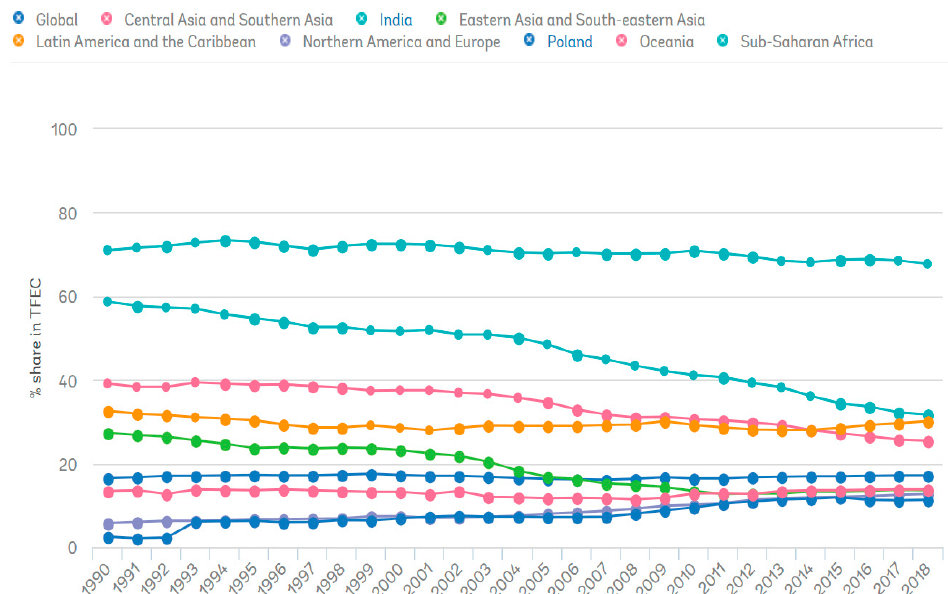
Figure 1. Renewable Energy Share in Total Final Energy Consumption 1990–2018 [11].